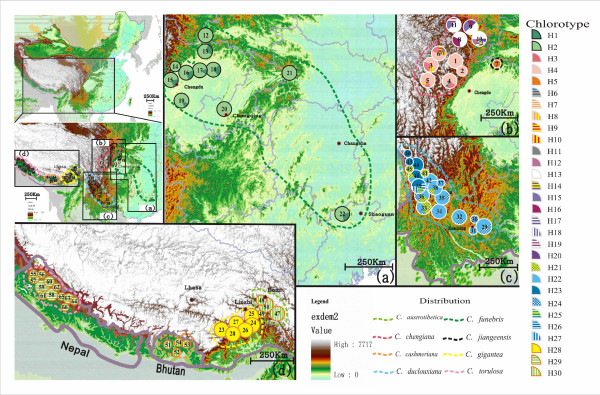
The distribution of eight cypress species and frequencies of plastid DNA haplotypes in each population surveyed. Upper left panel, a, b, c and d: Geographic ranges of eight cypress species and locations of populations sampled. The upper right panels a, b, c and lower panel d: plastid DNA haplotypes identified and the proportion of each present within populations of each species examined (circle size is proportional to the number of individuals surveyed per population). Further details of size and haplotype diversity of populations are provided in Additional File 1.